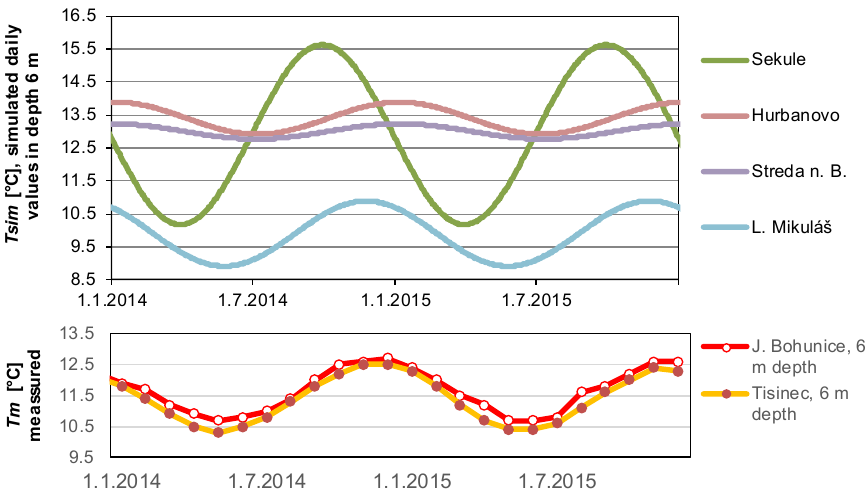
Figure 9. Comparison of the daily simulated soil temperatures ( Tsim ) at a 6 m depth at four stations (top) and the measured average monthly soil temperature ( Tm ) at a 6 m depth at the Jaslovské Bohunice and Tisinec stations (bottom) over the period 2014–2015.